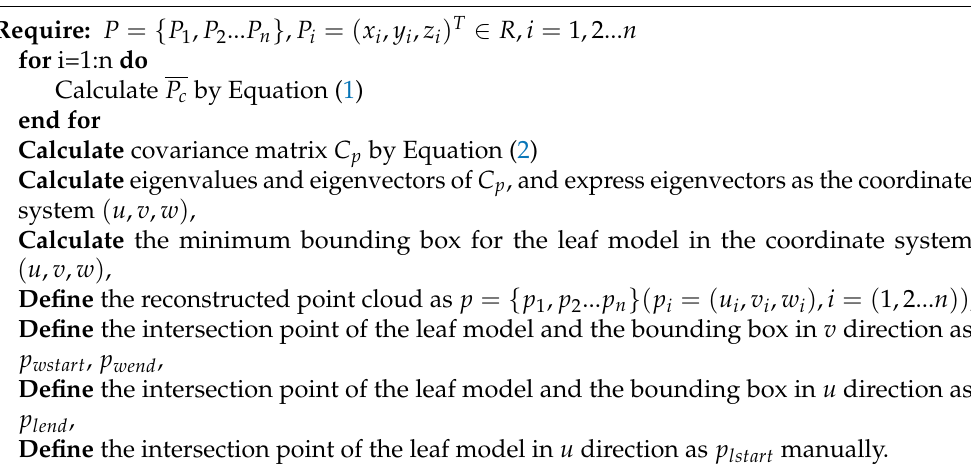
Algorithm 1 The algorithm of obtaining the measurement points of length and